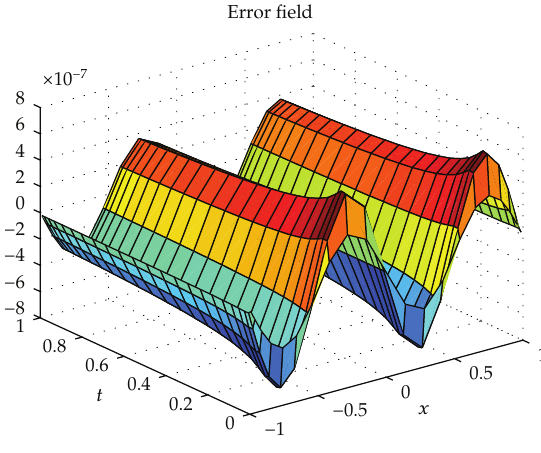
Figure 2: Error filed for μ (cid:6) 0 . 8 ,β (cid:6) − 0 .